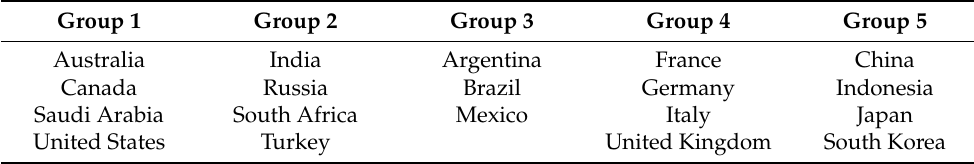
Table 1. G20 Nations in five groups as of 16 August